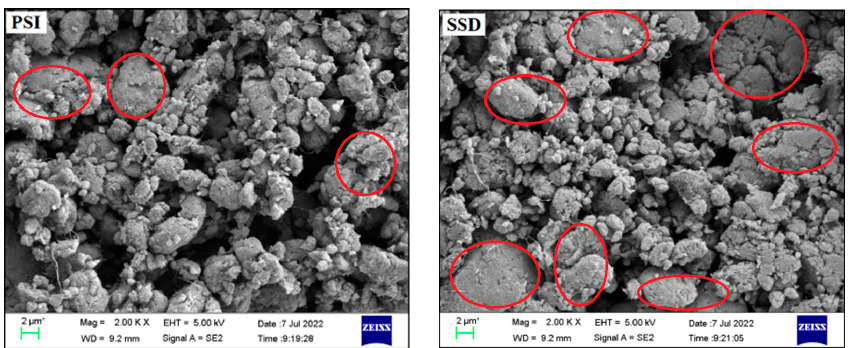
Figure 8. SEM micrograph of flexible electrode of PSI and SSD coating methods. The red circle means that the single-walled carbon nanotube electrode is agglomerated here.